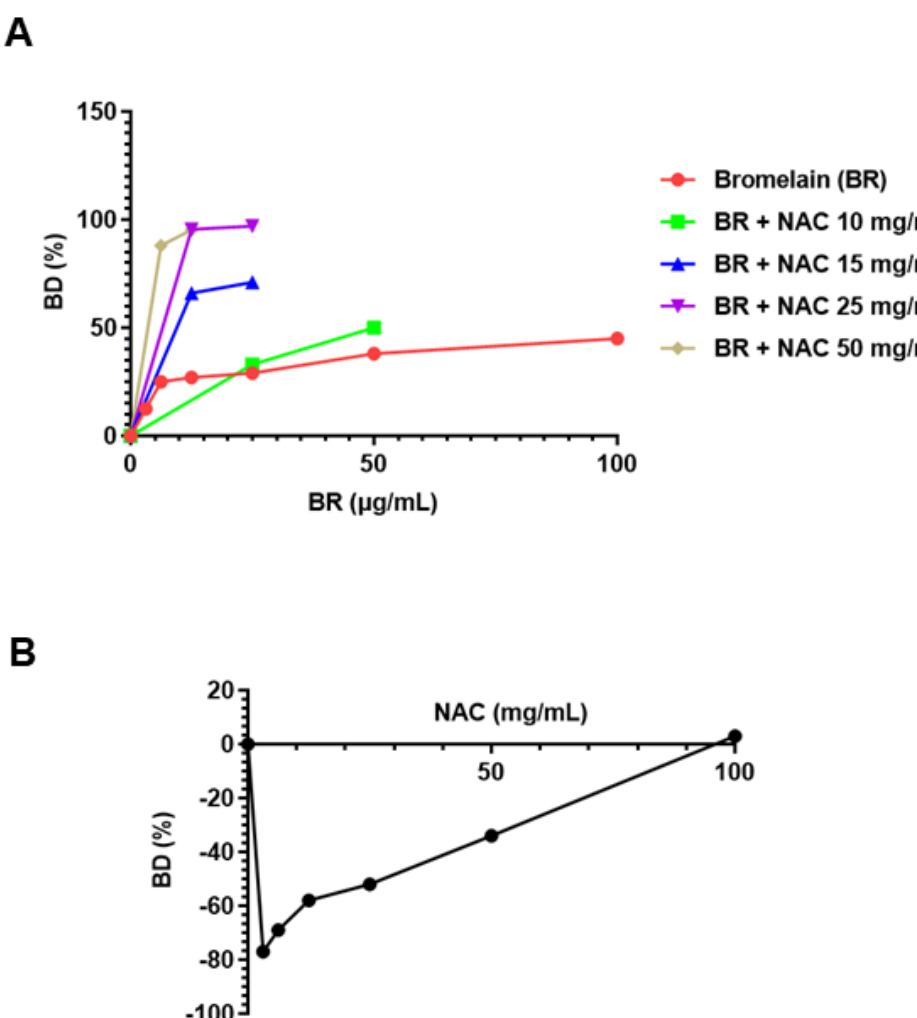
Figure 2. ( A ) Dissolution of biofilm formed by Pseudomonas aeruginosa PA01 3981 by bromelain and N-acetylcysteine. The graph shows that the addition of N-acetylcysteine (NAC) at 15, 25, or 50 mg/mL to bromelain increased the biofilm dissolution (BD) substantially (well above 80%). Bromelain (3.125–100 µg/mL) alone did not even produce 50% BD. ( B ) Dissolution effect of N-acetylcysteine on biofilm secreted by Pseudomonas aeruginosa PA01 3981. The graph shows a